Question: Describe this figure in one sentence.
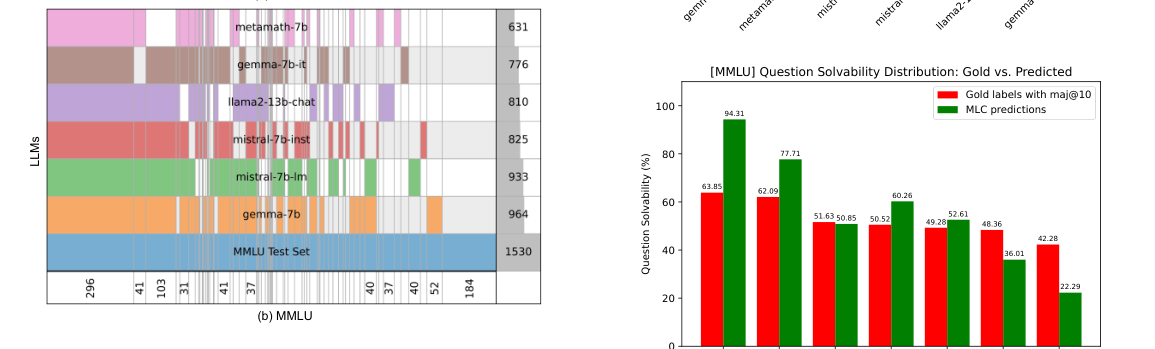
Answer: Distribution of queries from the GSM8K and MMLU test sets solved (score 1.0 with MAJ@10) by each LLM. The counts at the bottom of each figure denote the number of questions in each chunk, and those on the right denote the total number of questions solved by each LLM.